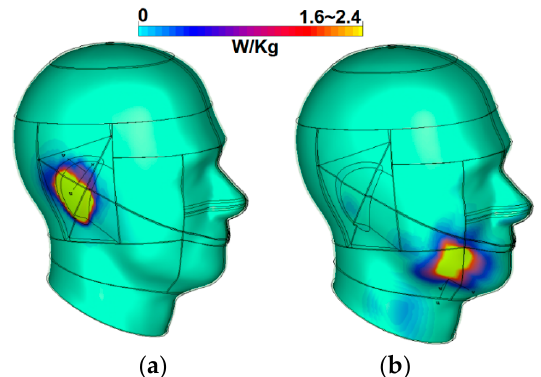
Figure 18. SAR analysis: ( a ) top and ( b ) bottom placements of the 5G smartphone phased array antenna.